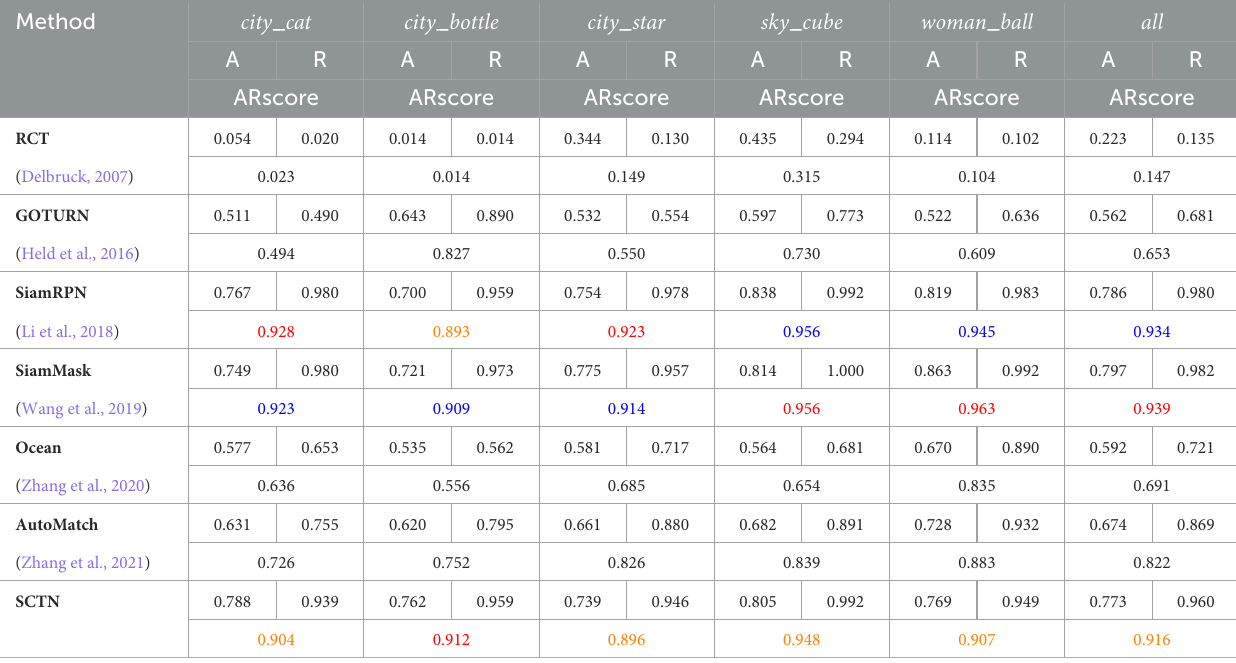
TABLE 2 Quantitative results on the five event-based test sequences from DVSOT21 dataset. Method